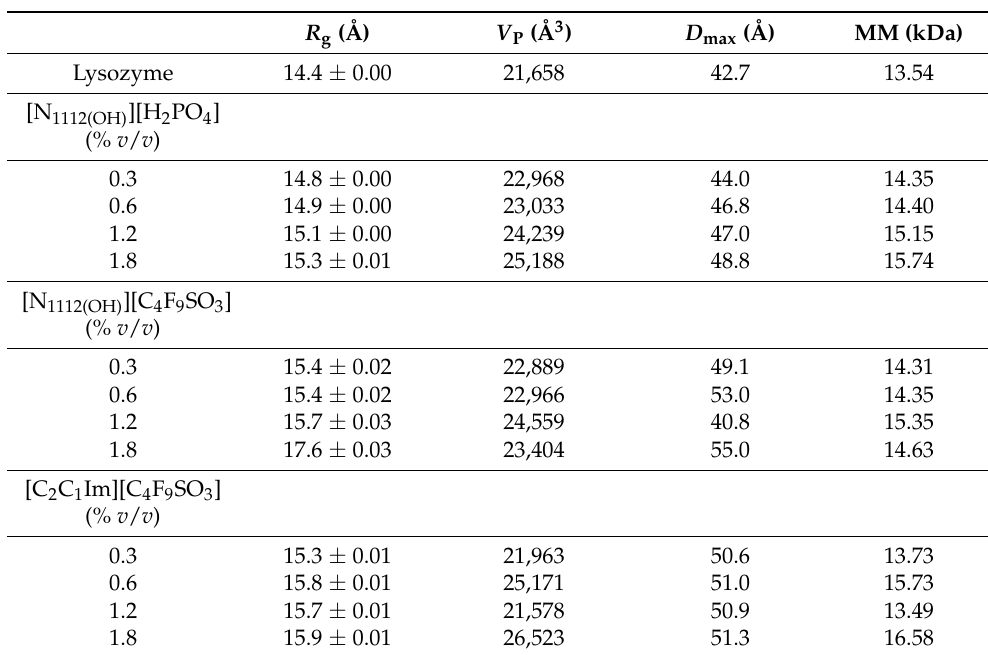
Table 3. SAXS structural parameters of Lys in the absence and presence of